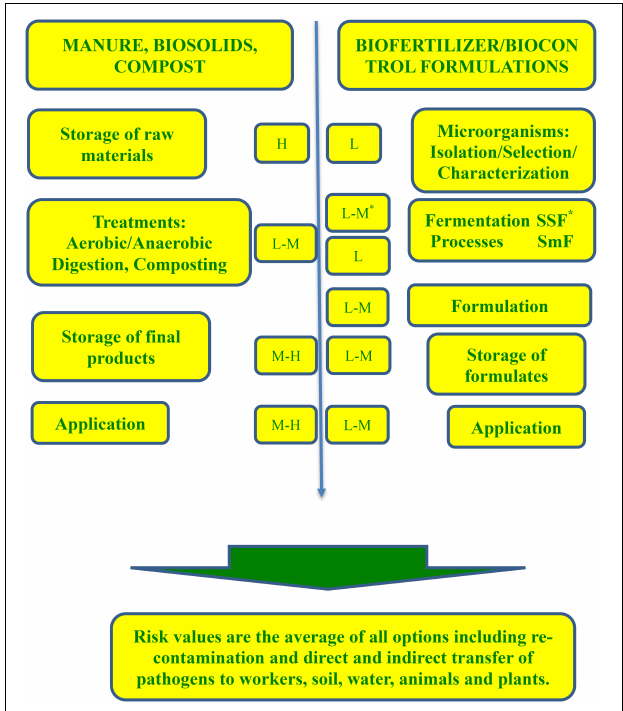
FIGURE 1 | Risks of contamination of microorganism-bearing fertilizer preparations during different stages of their production (L-low risk; M-medium risk; H-high